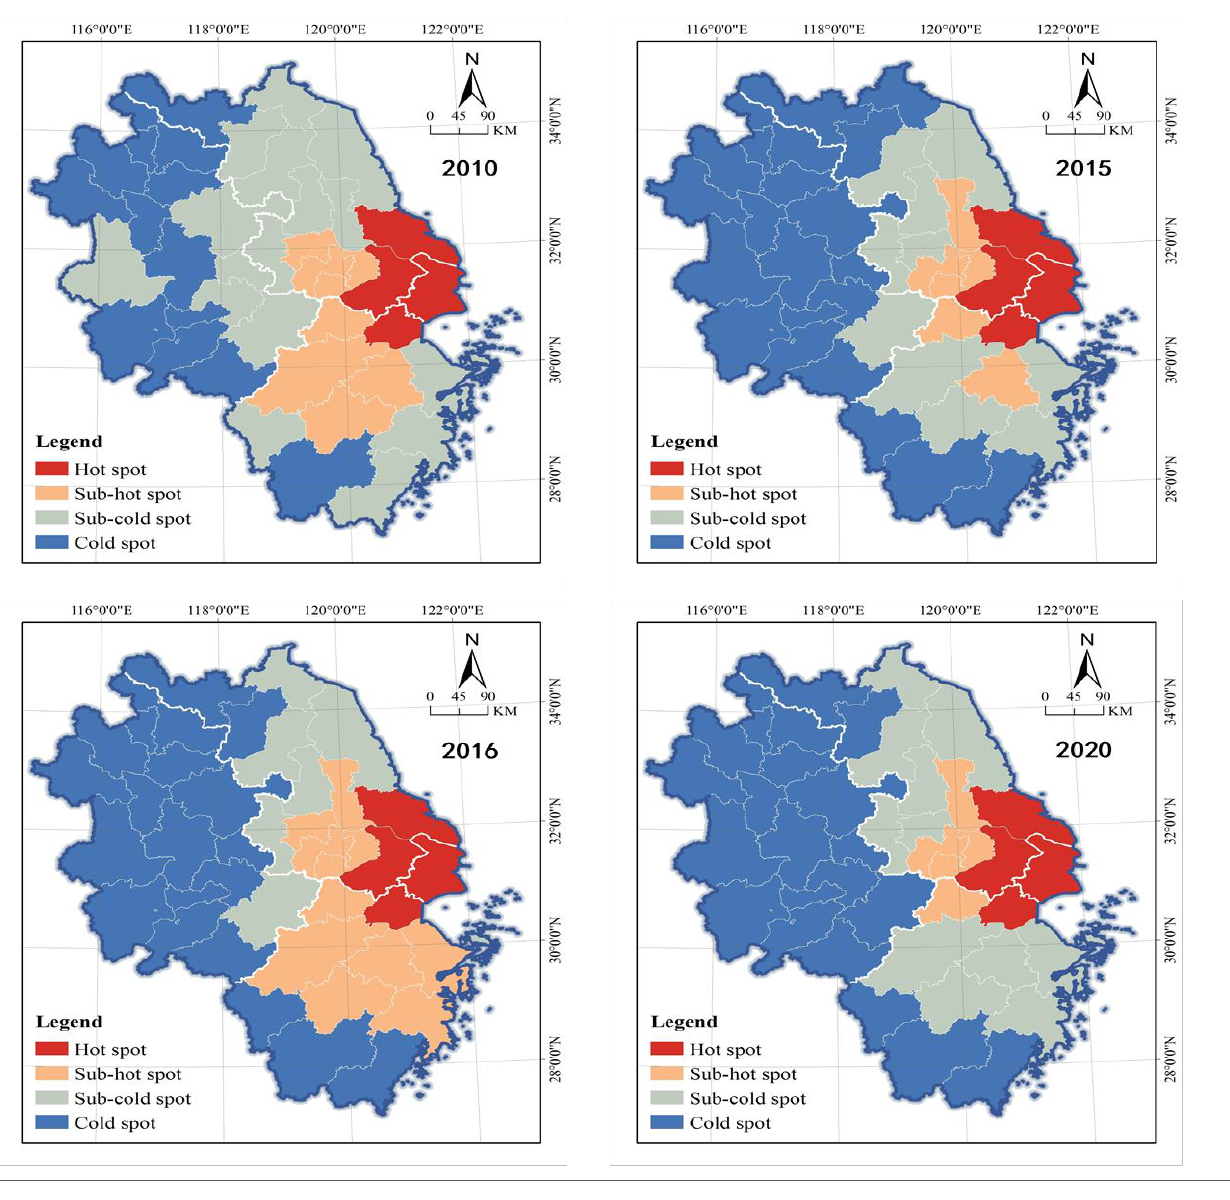
Figure 4. Analysis on the hot and cold area of real estate inventory in Yangtze River Delta.